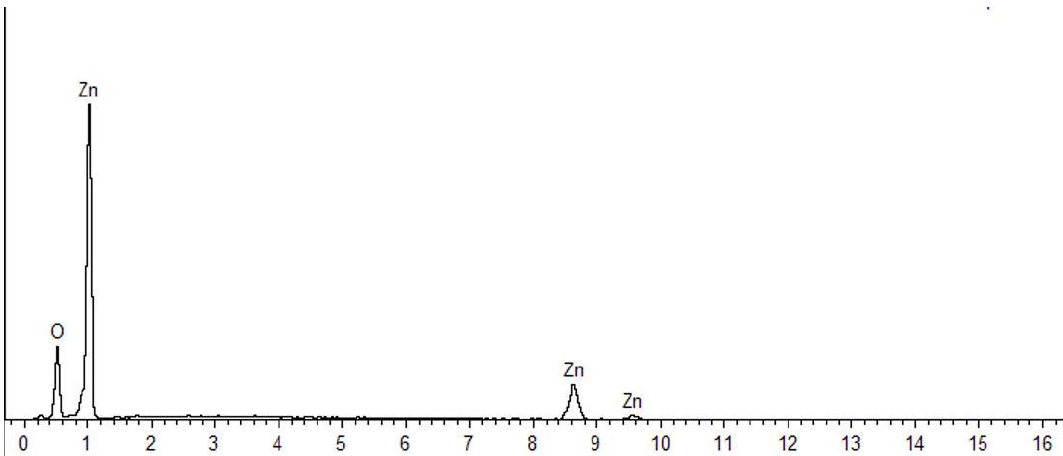
Figure 3. Energy-dispersive X-ray spectrum of ZnO NPs synthesized with heating (60 °C).